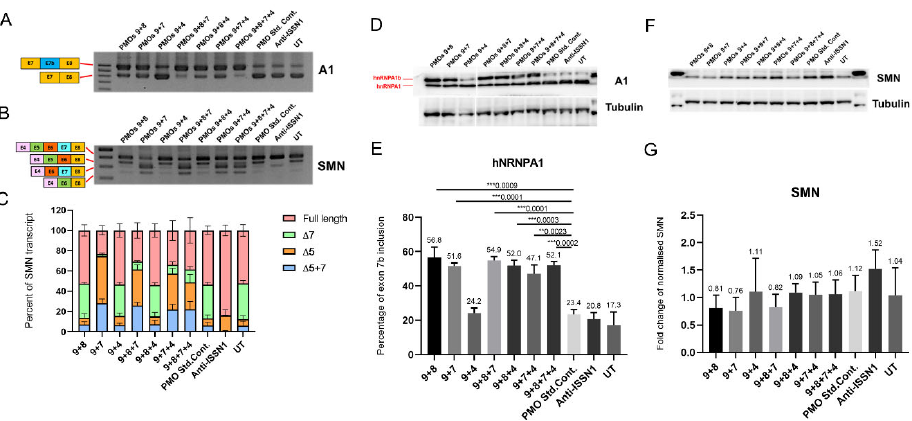
Figure 5. Gel images of RT ‐ PCR shows hnRNPA1 (827 bp) and hnRNPA1b (983 bp) transcripts ( A ). Panel (( B ) and ( C )) shows gel images of different isoforms of SMN2 transcripts missing exon5 ( Δ 5), missing exon 7 ( Δ 7) or missing both exons 5 and 7 ( Δ 5 + 7) with densitometric analysis of SMN2 transcript. Western blot analysis of hnRNPA1, FL ‐ SMN and β‐ tubulin expression in SMA fibroblasts transfected with selected seven different PMO cocktails as well as densitometric analysis of percent ‐ age of hnRNPA1b compared to SMN protein expression normalised against β‐ tubulin ( D – G ). Num ‐ bers above each bar graph indicates the average values of percentage of hnRNPA1b isoform ( E ) and the average fold change of increased SMN protein ( G ). ** = p < 0.01, *** = p < 0.001. 2.4. Transcriptomic Analysis of PMOs 9 + 7 + 8 Induced hnRNPA1b Isoform in SMA Fibro ‐ blasts We further investigated the effect of PMOs9 + 7 + 8 induced hnRNPA1b expression at the transcriptomics level in cultured SMA fibroblast. A panel of differentially expressed genes between the combined PMOs9 + 7 + 8 treated and untreated SMA fibroblasts was detected and is displayed as a volcano plot in Figure 6A. A panel of differentially expressed 3244 genes were identified, as the absolute log2 fold change was greater than 1.5 with p ‐ value lesser than 0.05. Expression of Survivin (BIRC5), Aurora kinase B (AURKB) and marker of proliferation ki ‐ 67 (MKI67) were approximately four ‐ fold less in the PMOs9 + 7 + 8 treated SMA fibroblasts compared to untreated fibroblast with the adjusted p ‐ value of 1.52 × 10 − 24 , 3.58 × 10 − 6 or 2.91 × 10 − 6 , respectively (Supplementary Table S3). A gene ontology analysis of these genes indicated that these differentially expressed genes involved the cycle control, mitosis, nuclear division and chromosome segregation (Figure 6B,C). We further performed a gene set enrichment analysis (GSEA) on this gene set and found that these genes were enriched in the cell cycle process, with a normalised enrichment score of − 1.8477 and a FDR q ‐ value of 0.00 (Figure 6D). FOXM1 and MYBL2 are strong candidates for regulating the cell cycle, nuclear division and chromosome segregation controlling protein, as either FOXM1 or MYBL2 was present in nine out of twenty enriched pathways identified by the GSEA analysis. FOXM1 has four isoforms, i.e., FOXM1A, FOXM1B, FOXM1C and FOXM1D, and the isoform specific RT ‐ PCR indicated that only FOXM1B was reduced by transfection with PMOs9 + 7 + 8, but not with PMOs 9 + 4 or in untreated SMA fibroblasts, while MYBL2 was also reduced in SMA fibroblasts treated with this PMO cocktail (Figure 7).